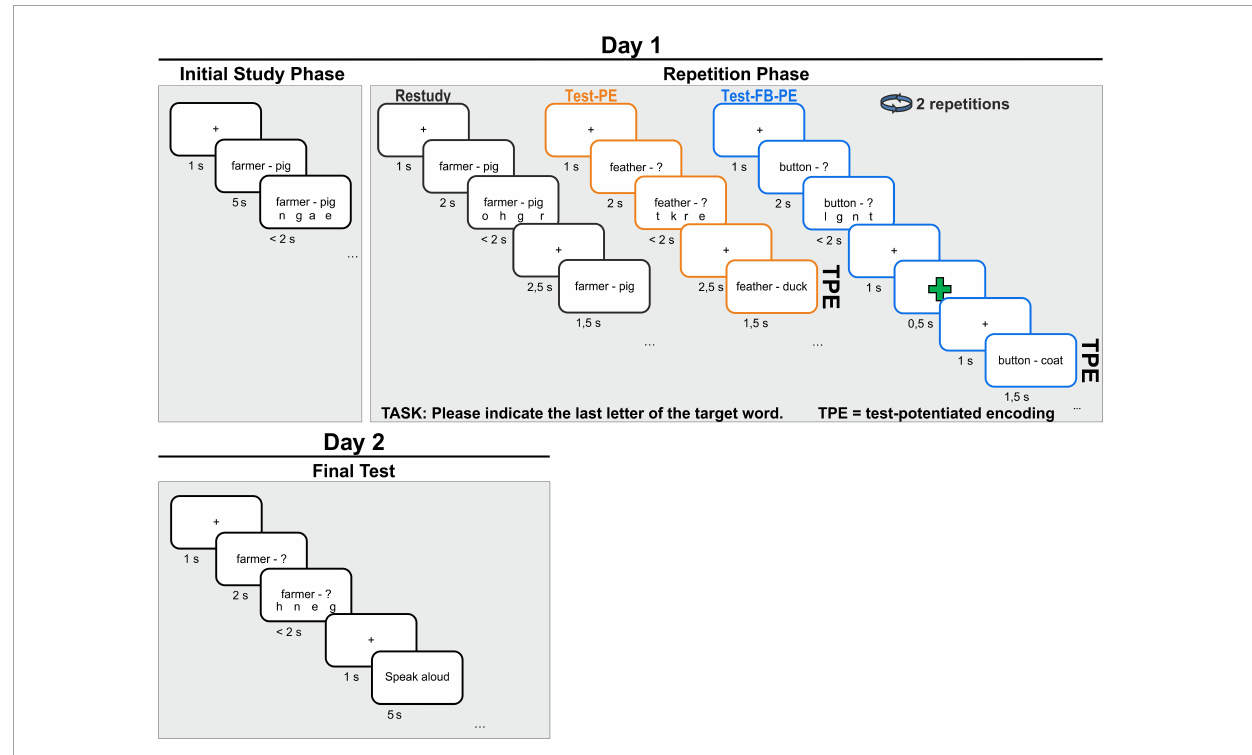
FIGURE1 Main schematic procedure of Experiment